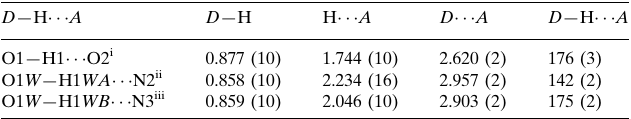
Hydrogen-bond geometry (A˚ , (cid:2)